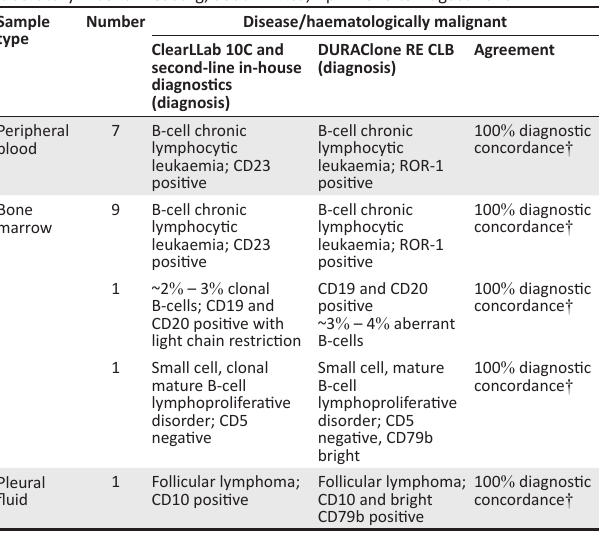
TABLE 4: Comparison of predicate reagents and DURAClone RE CLB reagent during the assessment of mature B-cell lymphoid proliferations undertaken at